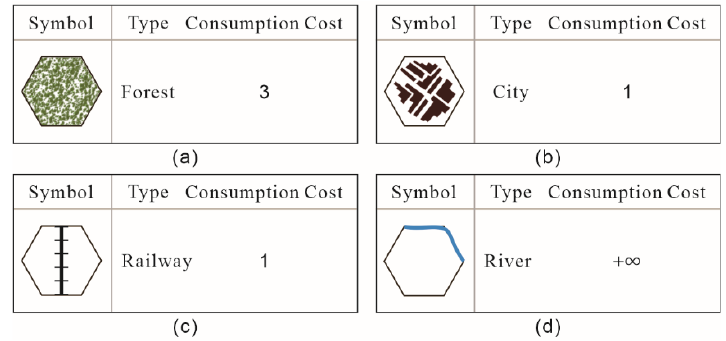
Figure 6. The sample grid: ( a ) Forest, ( b ) City, ( c ) Railway, ( d ) River